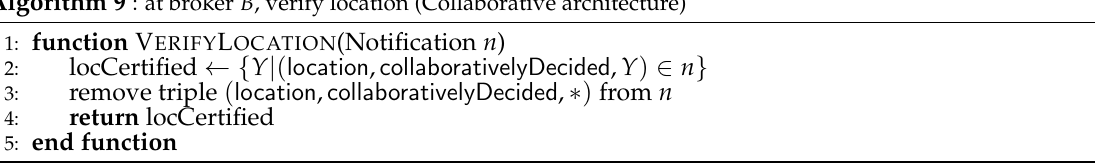
Algorithm 9 : at broker B , verify location (Collaborative